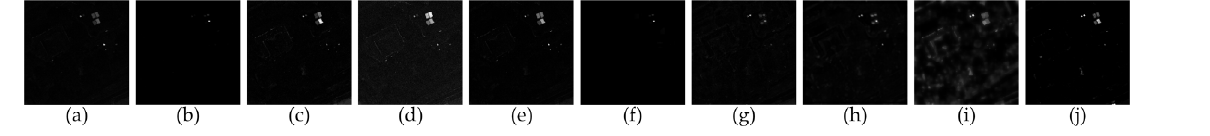
17 of 26 Figure 8. The detection results of different methods on the synthetic dataset: ( a ) RX; ( b ) LRX; ( c ) LSMAD; ( d ) LSDM–MoG; ( e ) CDASC; ( f ) 2S–GLRT; ( g ) BFAD; ( h ) SSFSCRD; ( i ) AED; ( j ) SCDF.